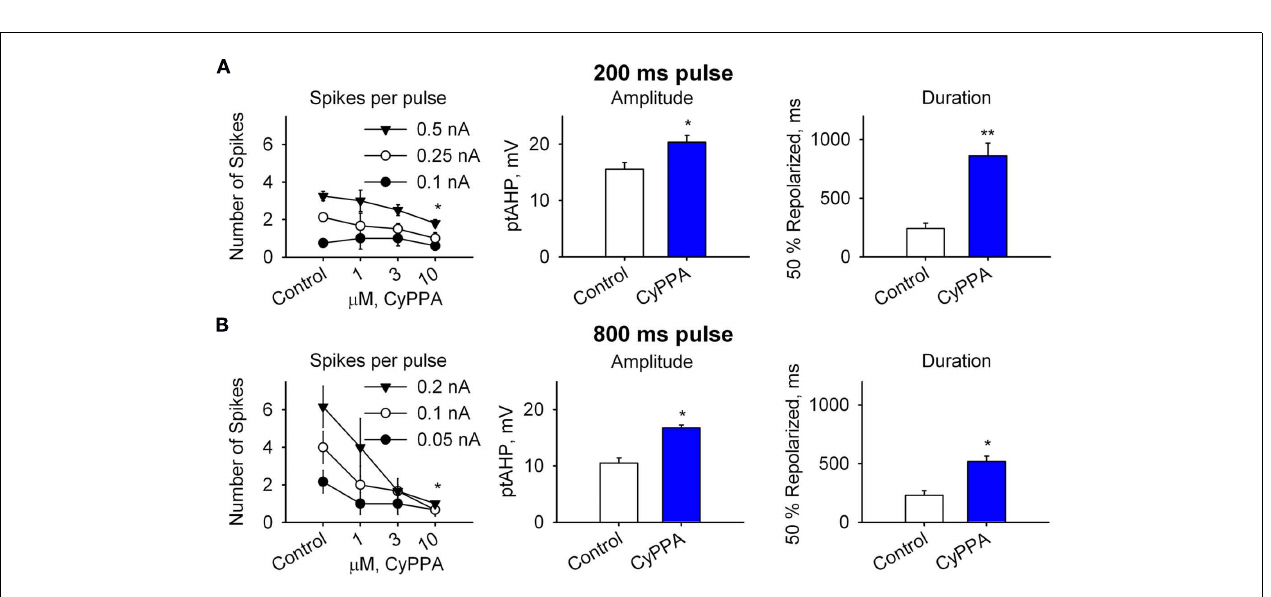
FIGURE 2 | CyPPA inhibits evoked spike trains and prolongates the post train afterhyperpolarizations (ptAHP) in midbrain slices from mice. (A) Representative spike trains evoked by a 200ms, 0.5nA current injection under control conditions (left), after 10 μ M CyPPA (middle), and with